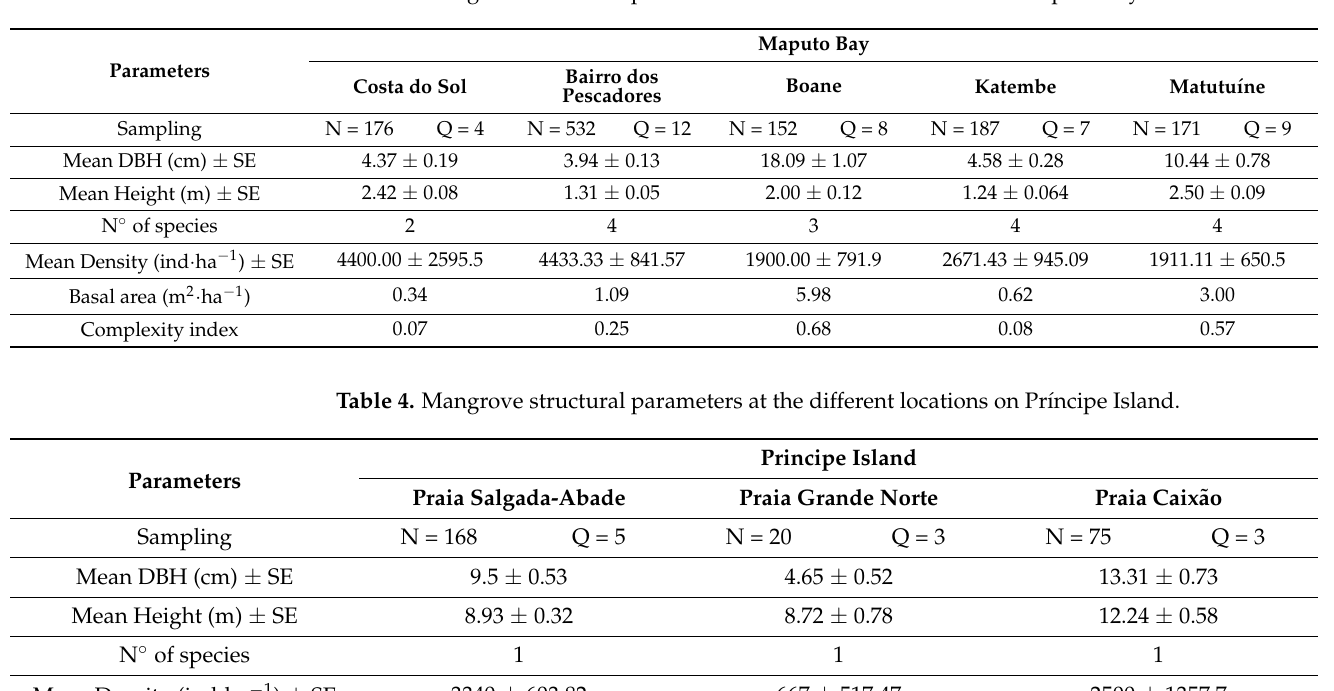
Table 3. Mangrove structural parameters at the different locations in Maputo Bay.